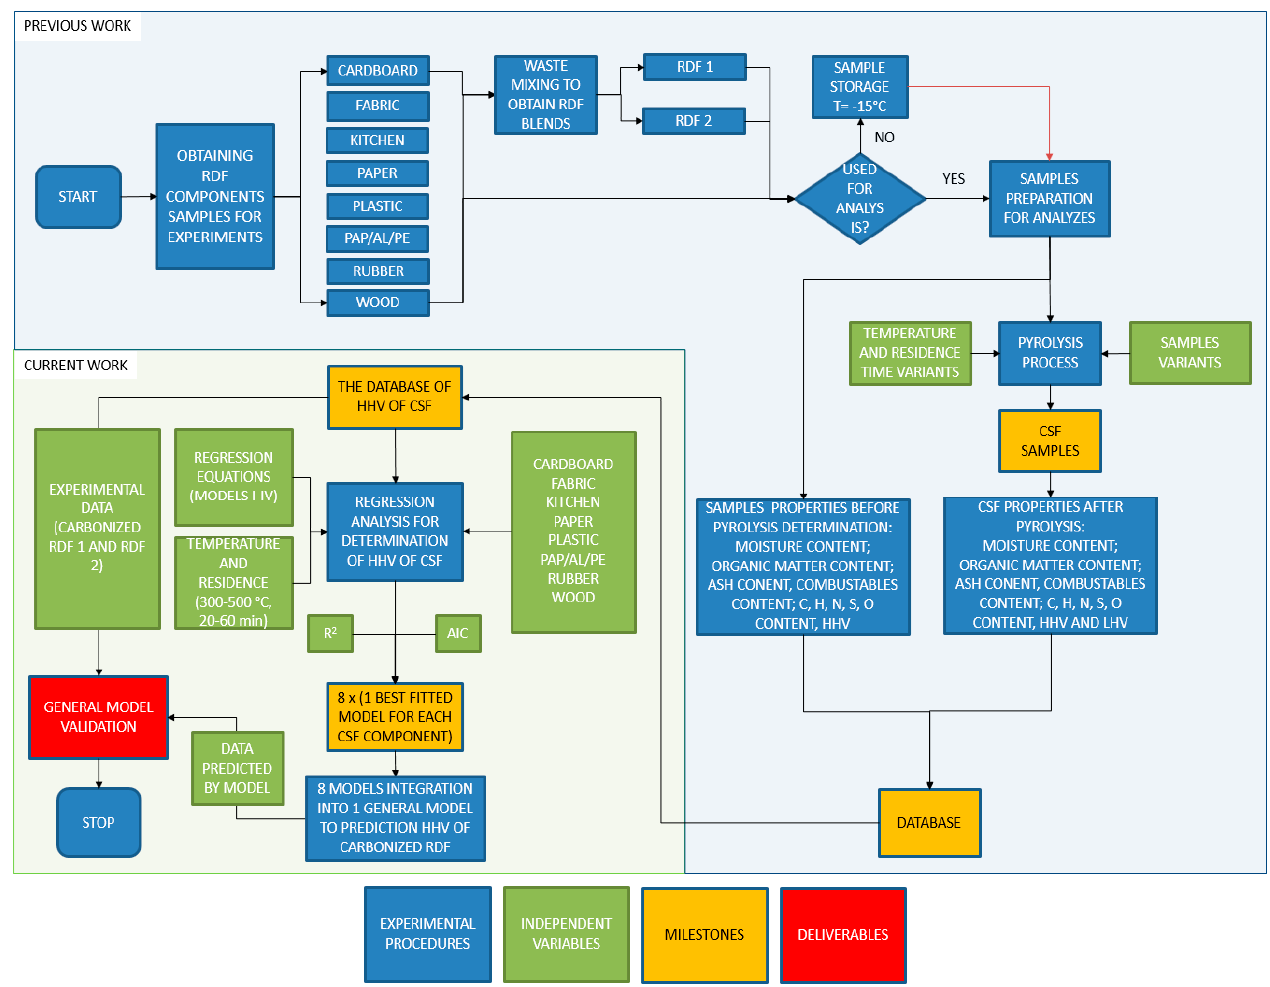
Figure 1. The experimental procedure flowchart for modeling and optimizing the higher heating value of solid carbonized fuel generated from blends of refuse-derived fuel by low-temperature pyrolysis.